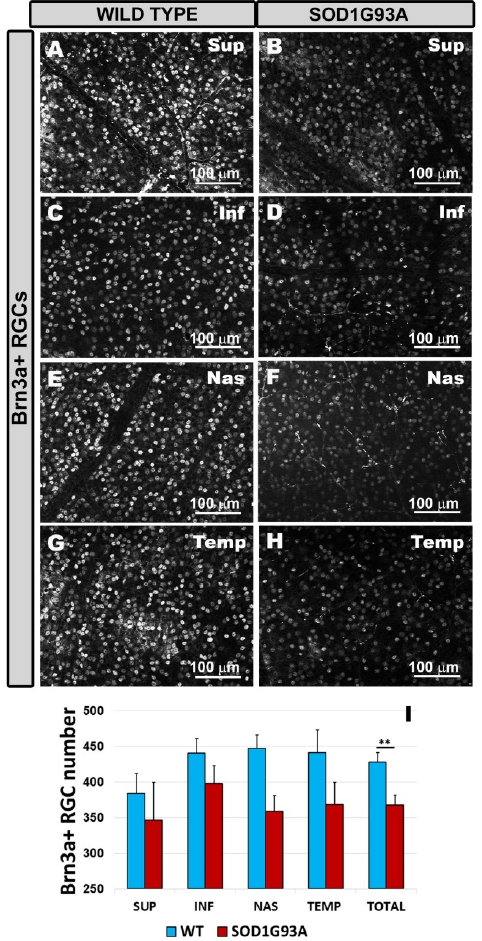
Figure 7. Number of Brn3a+ RGCs in the different retinal sectors superior ( A , B ), inferior ( C , D ), nasal ( E , F ), and temporal ( G , H ). Retinal whole-mounts are labeled with anti Brn3a in the wild type group ( A , C , E , G ) and the SOD1G93A group ( B , D , F , H ). The histogram shows the mean number ( ± standard deviation, SD) of Brn3a+ RGCs per area of 0.1502 mm 2 in the RGC layer (I). ** p < 0.01. Retinal ganglion cell (RGC). Wild type (WT). Superior (SUP), inferior (INF), nasal (NAS), and temporal (TEM). Number of retinas used in the experiment, WT: n = 6; and SOD1G93A: n = 6. Statistical test: Mann–Whitney U